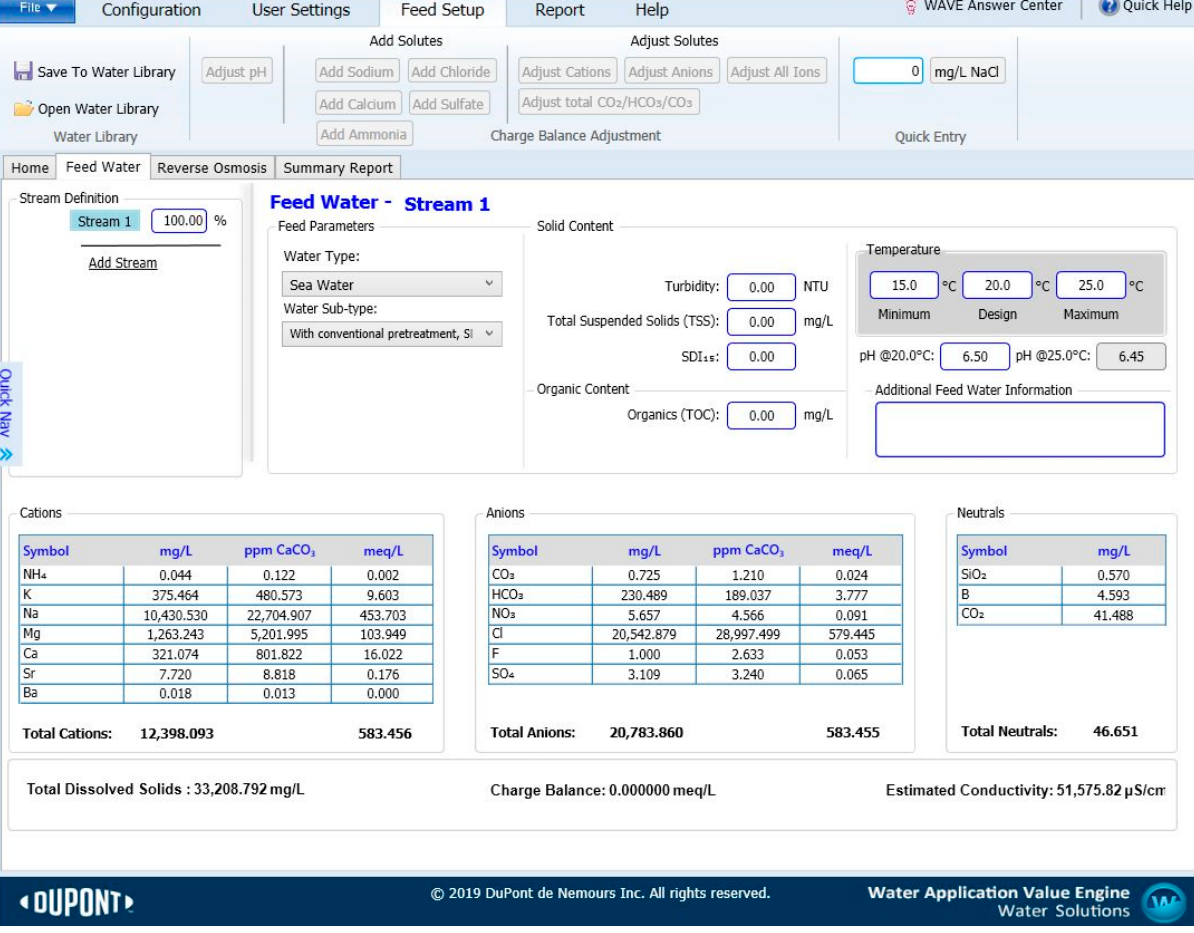
Figure 2. Screenshot of “Feed Water” (Water Application Value Engine (WAVE) software). 2019.